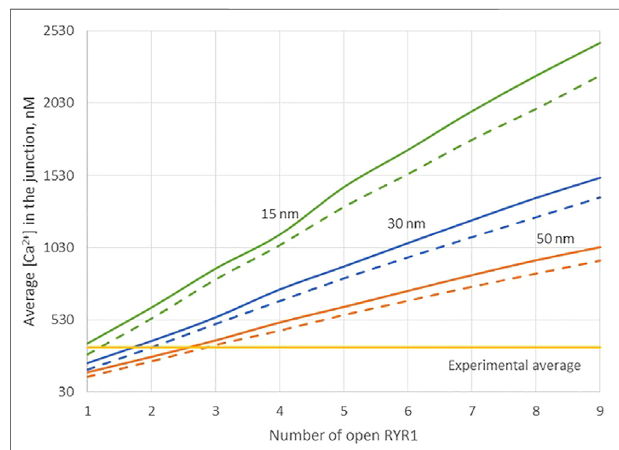
FIGURE 3 | In fl uence of the value of the distance between the PM and the ERM on the Ca 2+ microdomains in the ER-PM junction. The green curve (15 nm) corresponds to the situation considered in Figure 2 . Larger distances,bluecurve(30 nm)andorangecurve(50 nm)donotin fl uence the low contribution of the opening of the ORAI1 to the Ca 2+ concentration increase in the junction. Dotted lines represent junctional Ca 2+ concentration reached in the absence of ORAI1 channels.